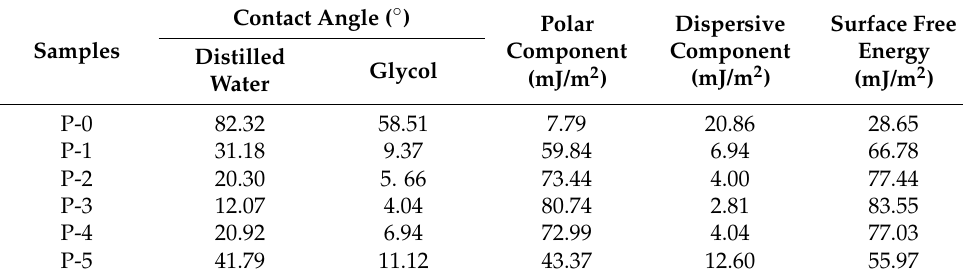
Table 6. Value of contact angles and surface free energy of the